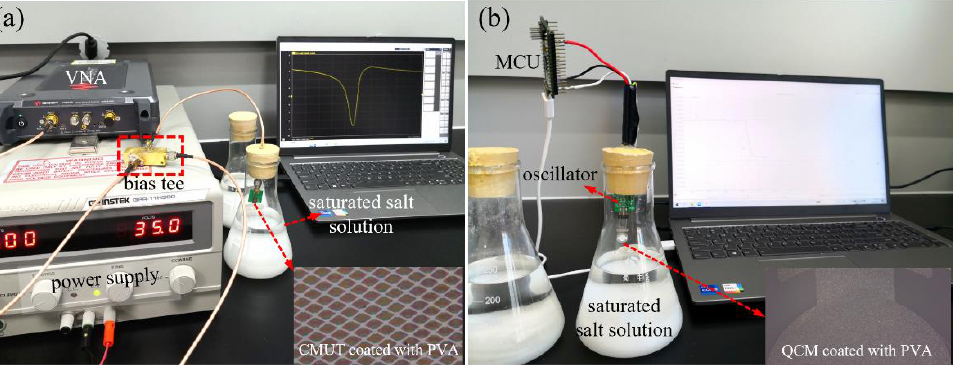
Figure 2. Experimental setups for the humidity sensing measurements of the CMUT ( a ) and QCM humidity sensors ( b